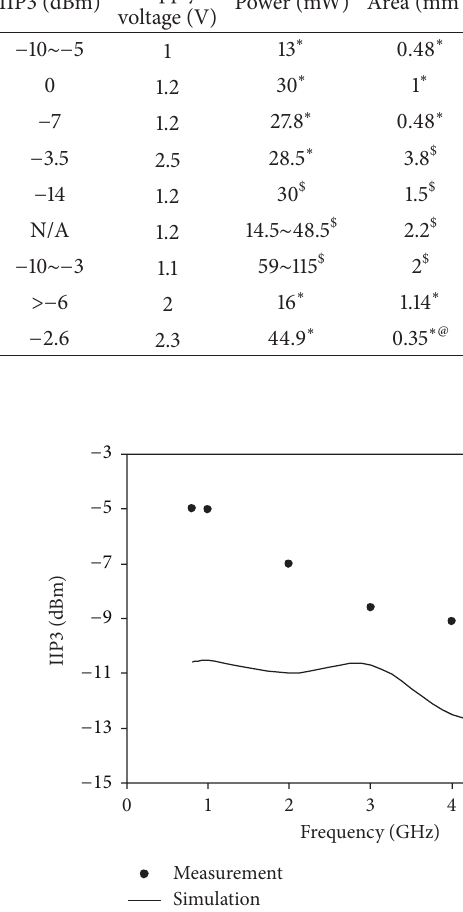
Table 1: Summary of the implemented and recently reported state-of-the-art CMOS wideband and tunable-band receiver front-ends. Frequency